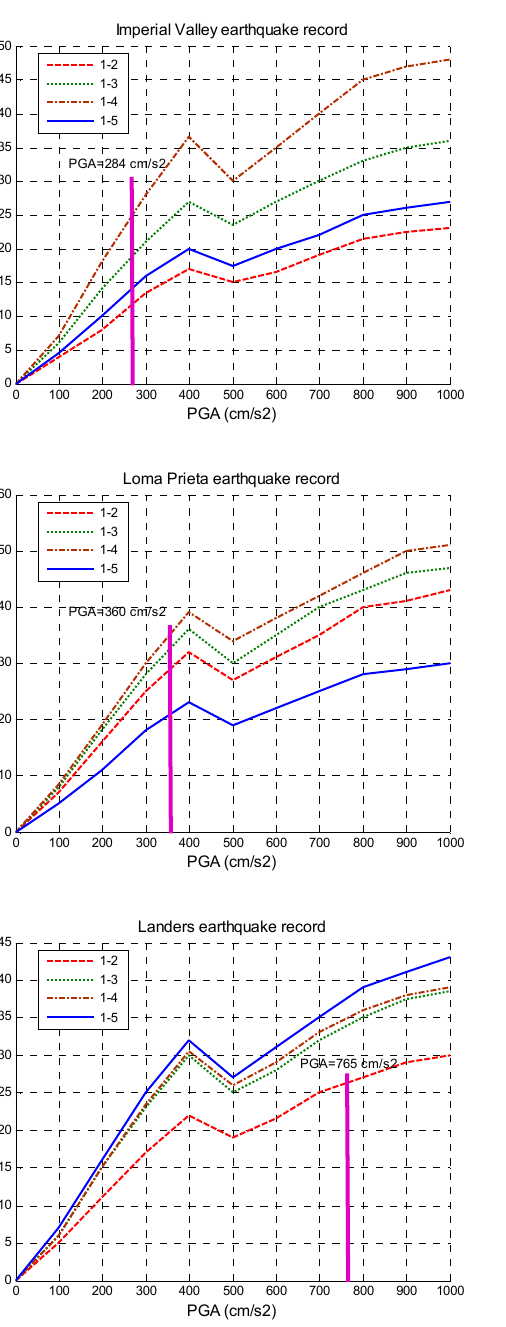
Figure 7. Examples of the results of the parametric analysis under various earthquakes scaled to di ff erent PGA values.